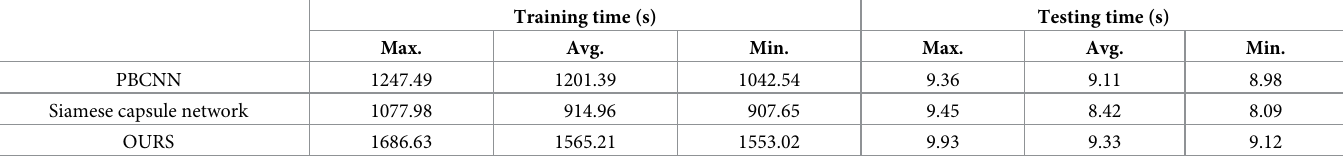
Table 5. Comparison of time complexity.